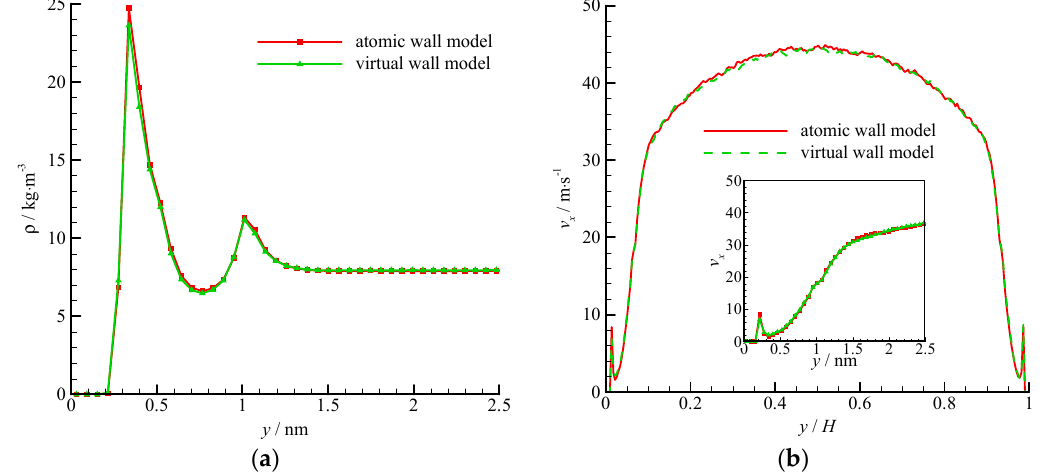
Figure 11. Density and velocity profiles of the atomic and virtual wall MD simulations in Poiseuille flow with rough wall, ( a ) density profile and ( b ) velocity profile. The non-dimensional wall distance (non-dimensionalized by the channel height H ) is used in large figure, and the dimensional wall distance is used in the zoomed-in figure.